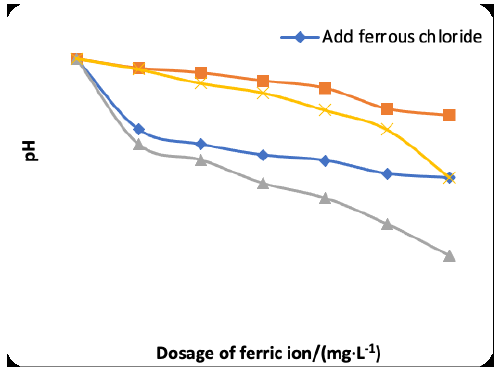
Fig. 1 Effects of adding ferric salt on pH